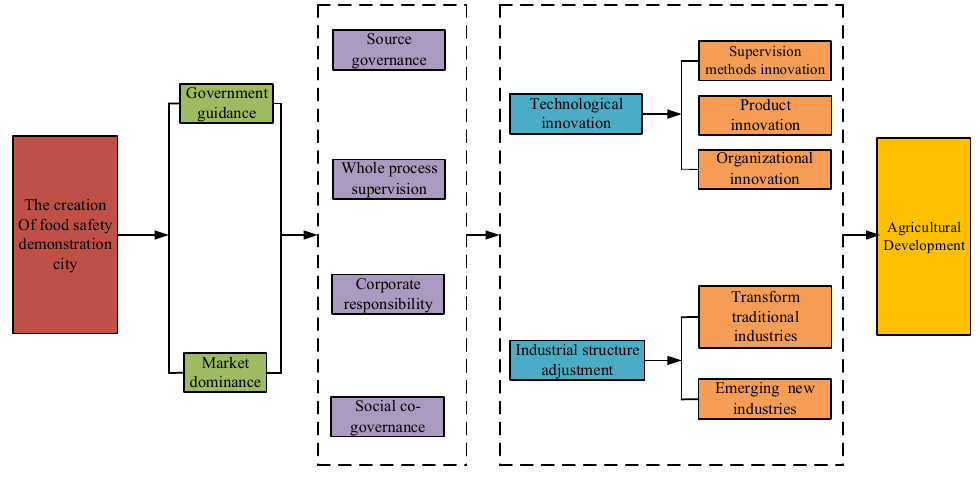
Figure 1. Mechanism of effects of the creation of food safety cities on agricultural development. The National Food Safety Demonstration City Standard (2017 Edition) proposed that cities participating in the creation of food safety demonstration cities should strictly im- plement the source supervision of agricultural products and improve the inspection and testing capabilities of agricultural products. Among the prerequisites for the